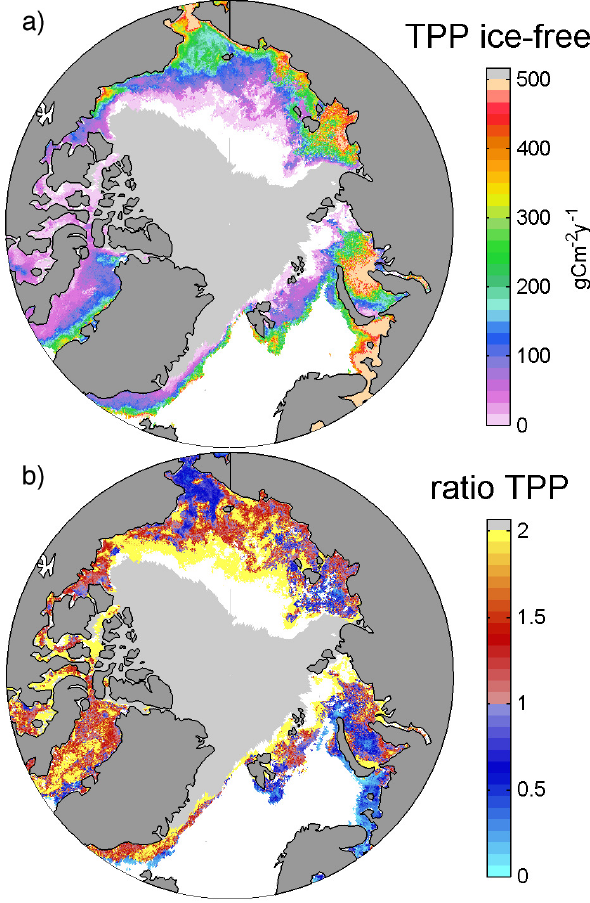
Fig. 6. Summary statistics for whole Arctic during 2007. (a) Total vertically-integrated primary production for the seasonal ice zone for the full year. (b) Ratio of average production rate in MIZ pe- riod to that for the rest of the ice-free period. Warmer colours (red- yellow) indicate regions where the MIZ exhibits higher rates of pro- ductivity than the rest of the year. In both panels, the land mask is shown in dark grey, light grey areas correspond to permanent sea- ice cover, and white areas to open-ocean or missing